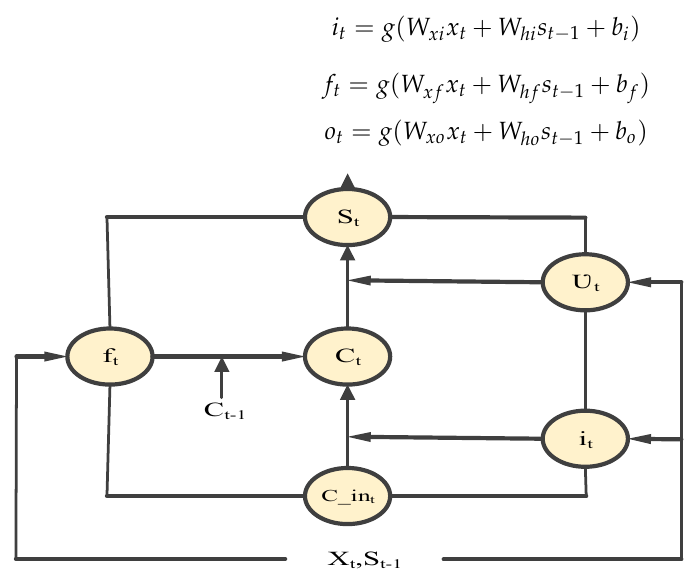
Figure 3. The basic unit memory cell.